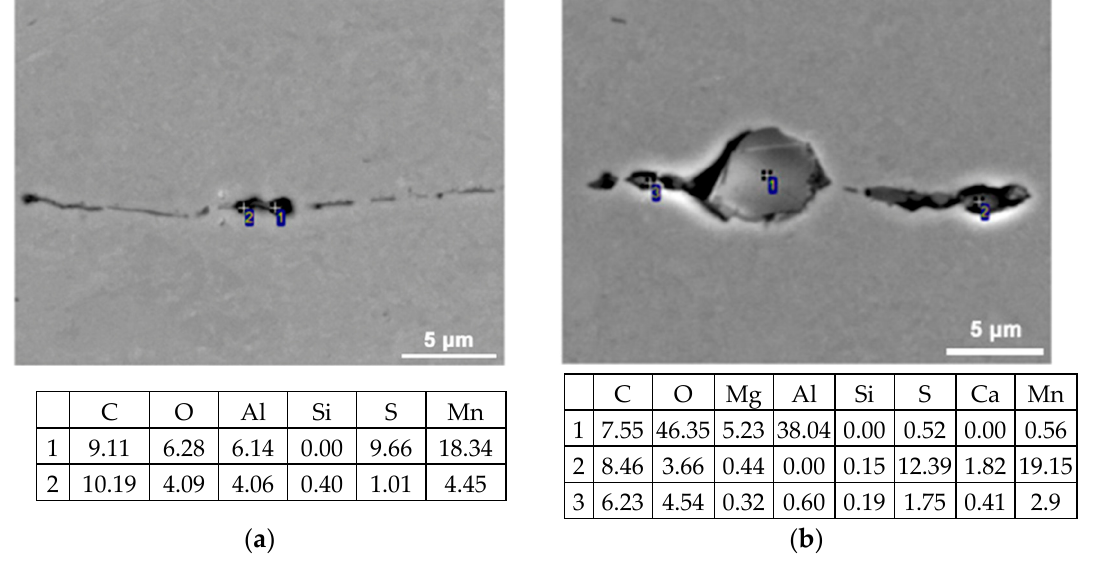
Figure 3. View and composition of inclusions in samples of the batches: ( a ) No. 1-1; ( b ) No. 2-2.